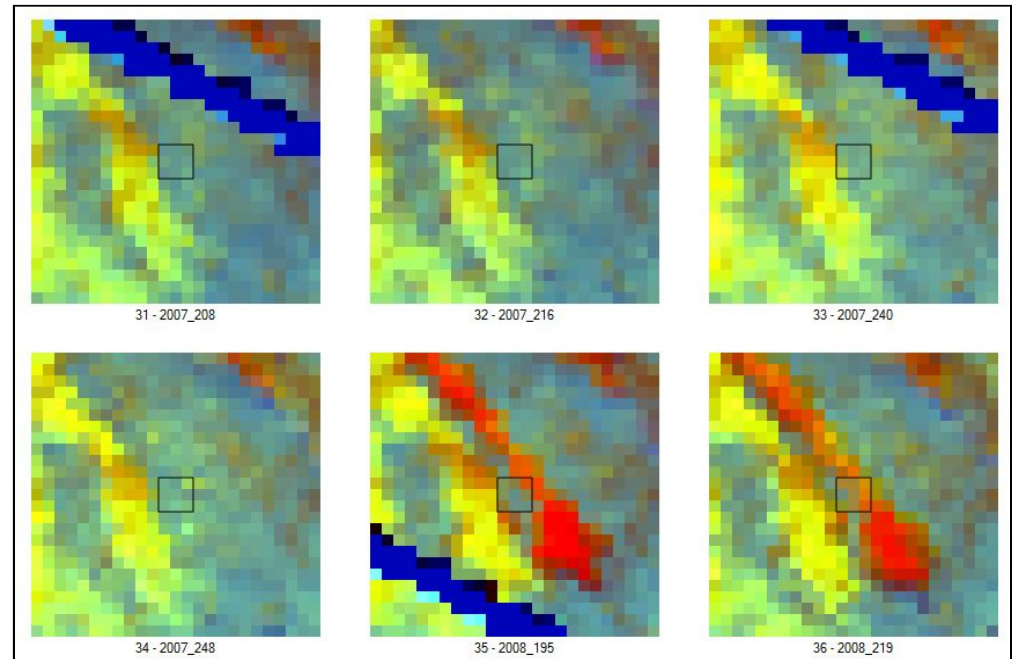
Figure 4. Pre- and post-disturbance tasseled-cap image chips from the stack of Landsat images used in LandTrendr run. Colors are assigned to the red, green, and blue color hues are tasseled-cap Brightness, Greenness, and Wetness, respectively. Dark blue streaks correspond to Landsat 7 missing scan lines, yellows to broadleaf shrub or tree; red to open soil or rock; light blue and cyan to needle-leaf forest and mixed needle- and broad-leaf forest.